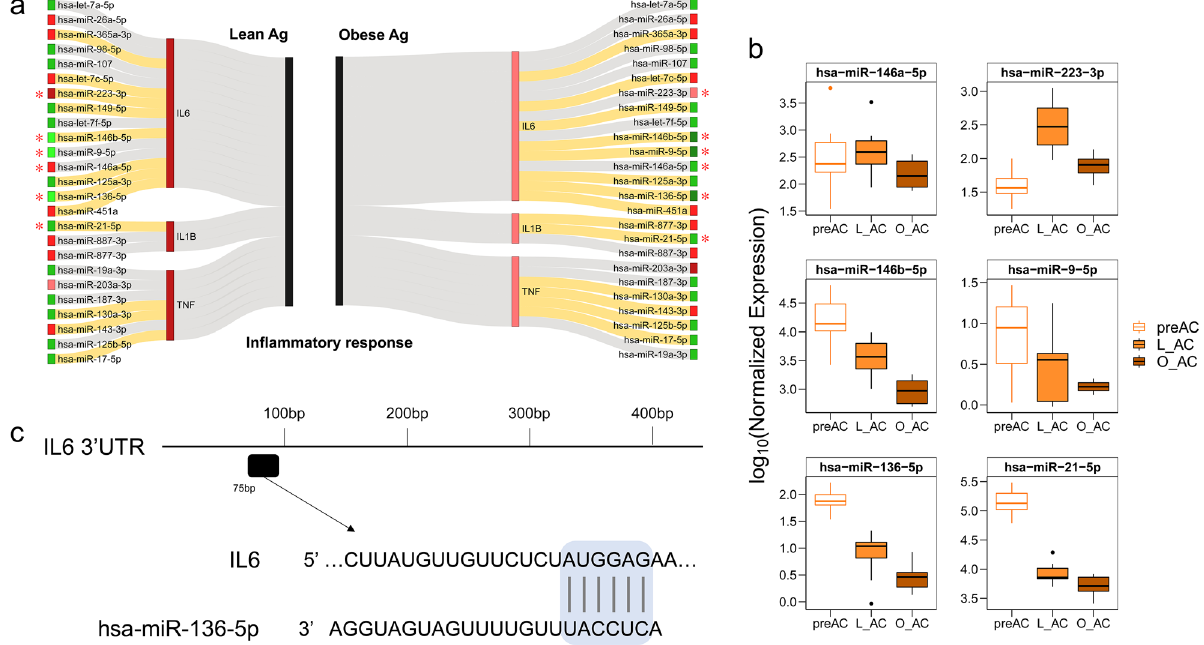
Figure 5. Analysis of DEMs that are preditcted to target inflammatory genes. ( a ) Sankey plot of miRNAs targeting inflammatory genes ( IL6, IL-1β , and TNF-α ). The miRNAs listed in the leftmost panel and rightmost panel are miRNAs that are predicted to target the three inflammatory genes identified from L_Ag and O_Ag, respectively. Downregulated and upregulated miRNAs are colored green and red, respectively. The depth of the colors reflects the differences in the absolute log 2 FC (i.e., | log 2 FC| between L_Ag and O_Ag. For instance, the | log 2 FC| of upregulated miR-223-3p is greater in L_Ag (dark red) than in O_Ag (light red) by more than 1; the | log 2 FC| of downregulated miR-146b-5p is greater (dark green) in O_Ag than in L_Ag (light green) by more than 1. In contrast, because the difference in the | log 2 FC| of let-7a-5p between L_Ag and O_Ag is less than 1, the same depth of color is used for both L_Ag and O_Ag). The miRNAs with an absolute log 2 FC difference of 1 or more between L_Ag and O_Ag are marked with asterisks. The miRNAs connected with the orange and gray lines are DEMs and non-DEMs, respectively. ( b ) Boxplots of the expression levels of miRNAs marked with asterisks in ( a ). Log10-transformed DESeq2-normalized expression levels (Y-axis) are plotted against each cell type (X-axis). ( c ) Example view of miR-136-5p binding sites predicted by TargetScan that targets IL-6 . A diagram of the 3’ UTR of human IL-6 was drawn based on RefSeq